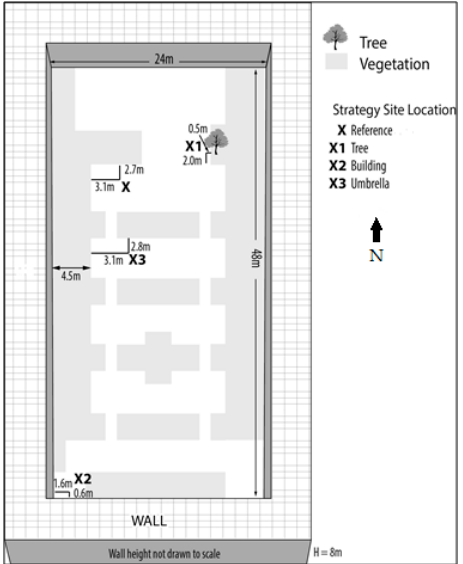
Figure 2. Diagram of the residential setting. Light gray areas indicate vegetative surfaces (such as grass, flowers, and bushes), white surface areas indicate built areas (such as concrete and brick). X is the location of the reference site, X1 is the location of the tree strategy site, X2 is the location of the building strategy site, and X3 is the location of the umbrella strategy site. Diagram is not to scale.